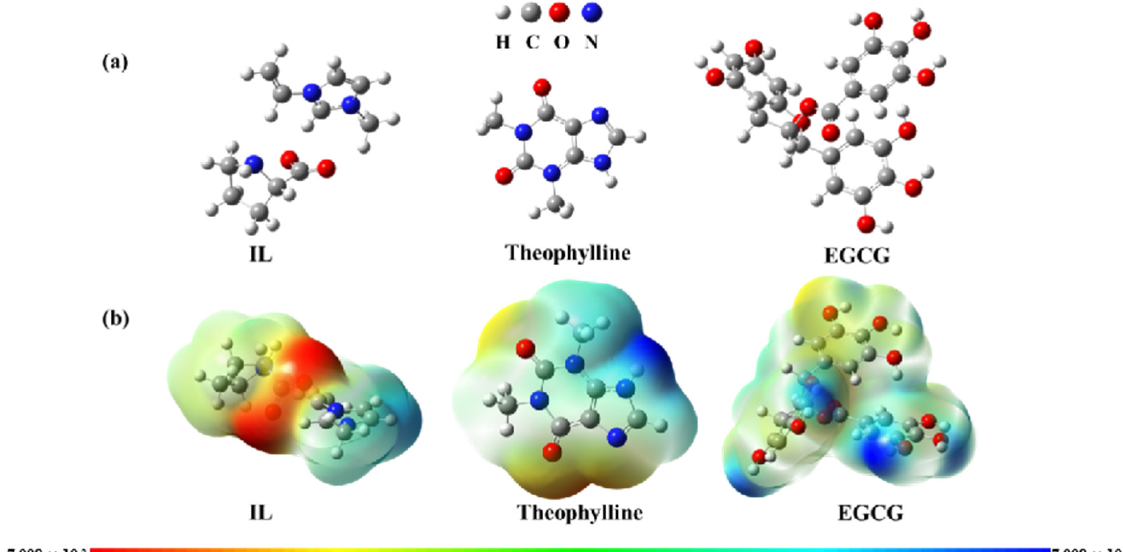
Figure 8. ( a ) The optimized molecular geometric structure of (ViIm) 2 C 6 (L-Pro) 2 (IL),